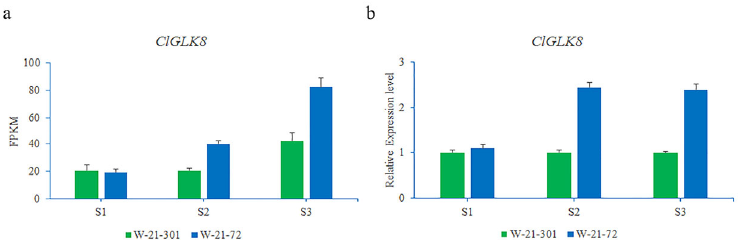
Figure 7 . Expression analysis of ClGLK8 in the pericarp of two cultivars of watermelon. ( a ) The FPKM expression values of ClGLK8 at three stages in two cultivars. ( b ) The RT–qPCR data of ClGLK8 at three stages in two cultivars.